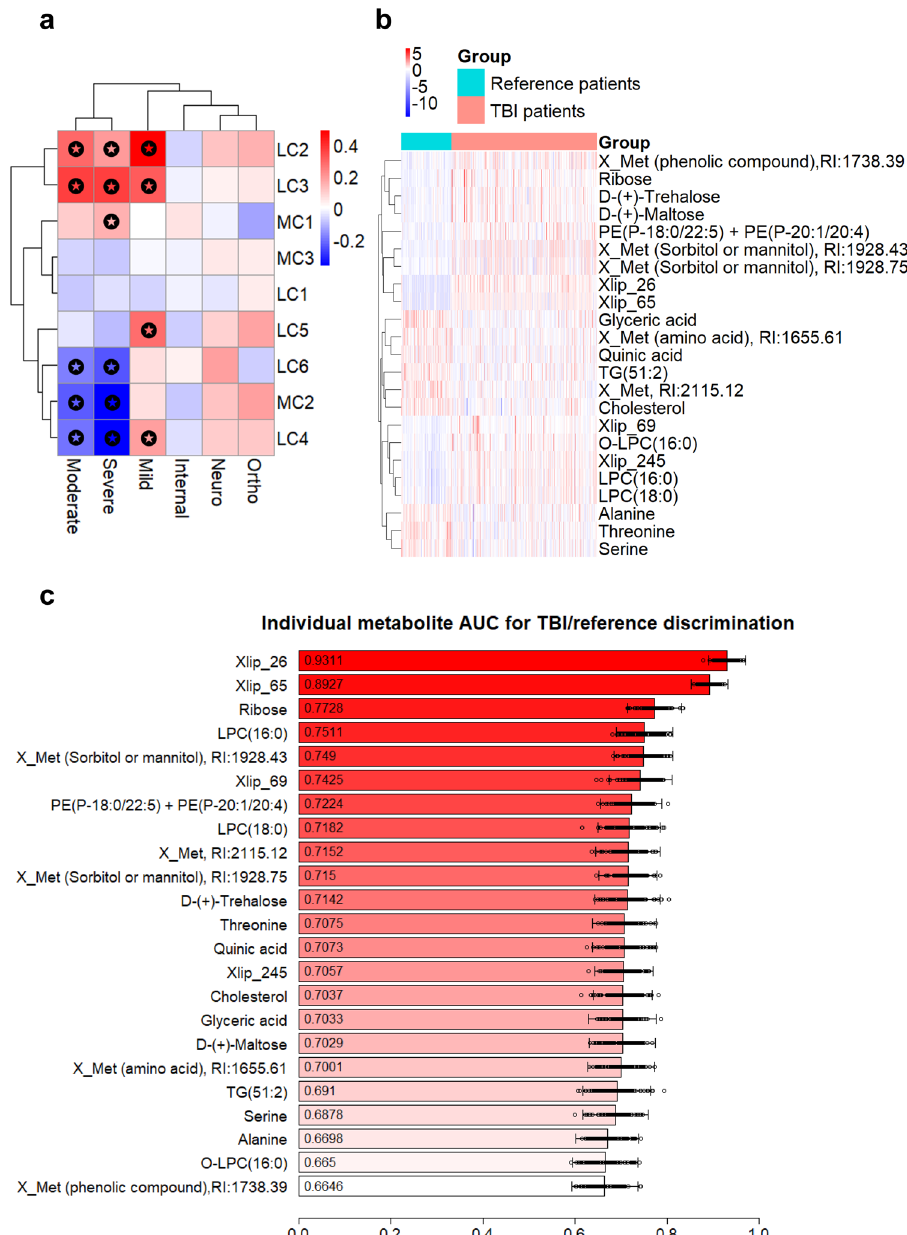
Fig. 2 Survey of metabolome in TBI patients and controls. a Polar metabolite (MC) and lipid (LC) clusters across the study groups. Mean of orthopedic and internal medicine controls was used as a reference, and the signi fi cant differences between the groups and the reference are marked. b Heatmap of the TBI-reference patient groups and the top 23 metabolites as selected by the overlap of the random forest feature selection and the Welch t test signi fi cant feature evaluation. Unknown polar metabolites and lipids are marked as Xmet and Xlip, respectively c Individual discriminatory performance for the top 23 metabolites. Each metabolite was used in a logistic regression model as predictor, with group af fi nity as response. The performance was averaged on 100 model runs of 70 – 30% data splits. Data are presented as mean values with the individual run performances as points ( n = 100) and aggregated 95%